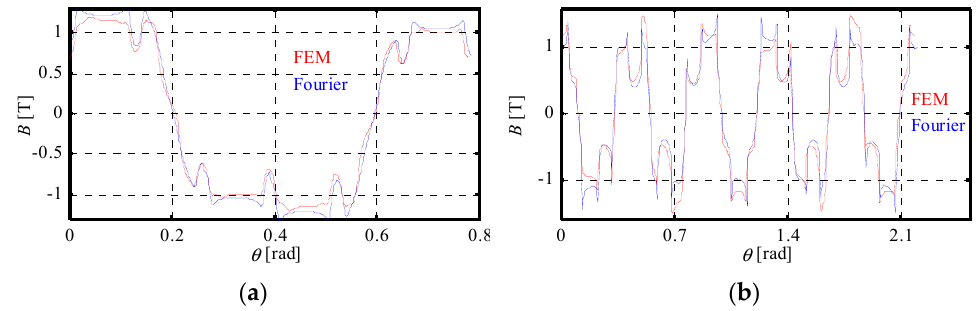
Figure 8. The overall flux density in the air gap in load condition: ( a ) Qs48p8, ( b ) Qs36p15.